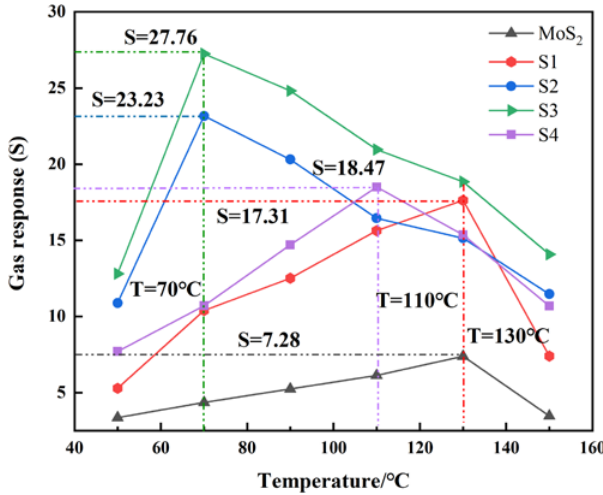
Figure 8. Temperature characteristic curve of gas-sensing material to 15 μL/L C 2 H 2 .